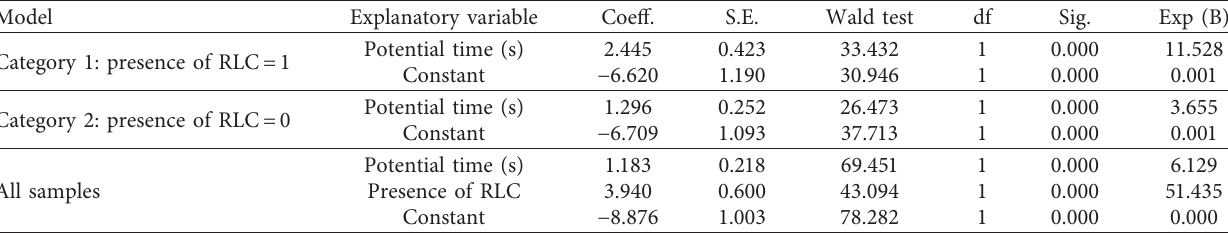
Table 3: Stopping probability models for stop-and-go